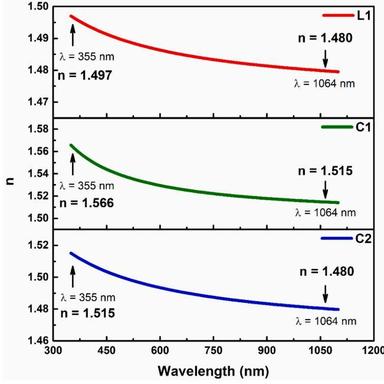
Changes in the linear refractive index with wavelength for the specified L1, C1 and C2 thin films.